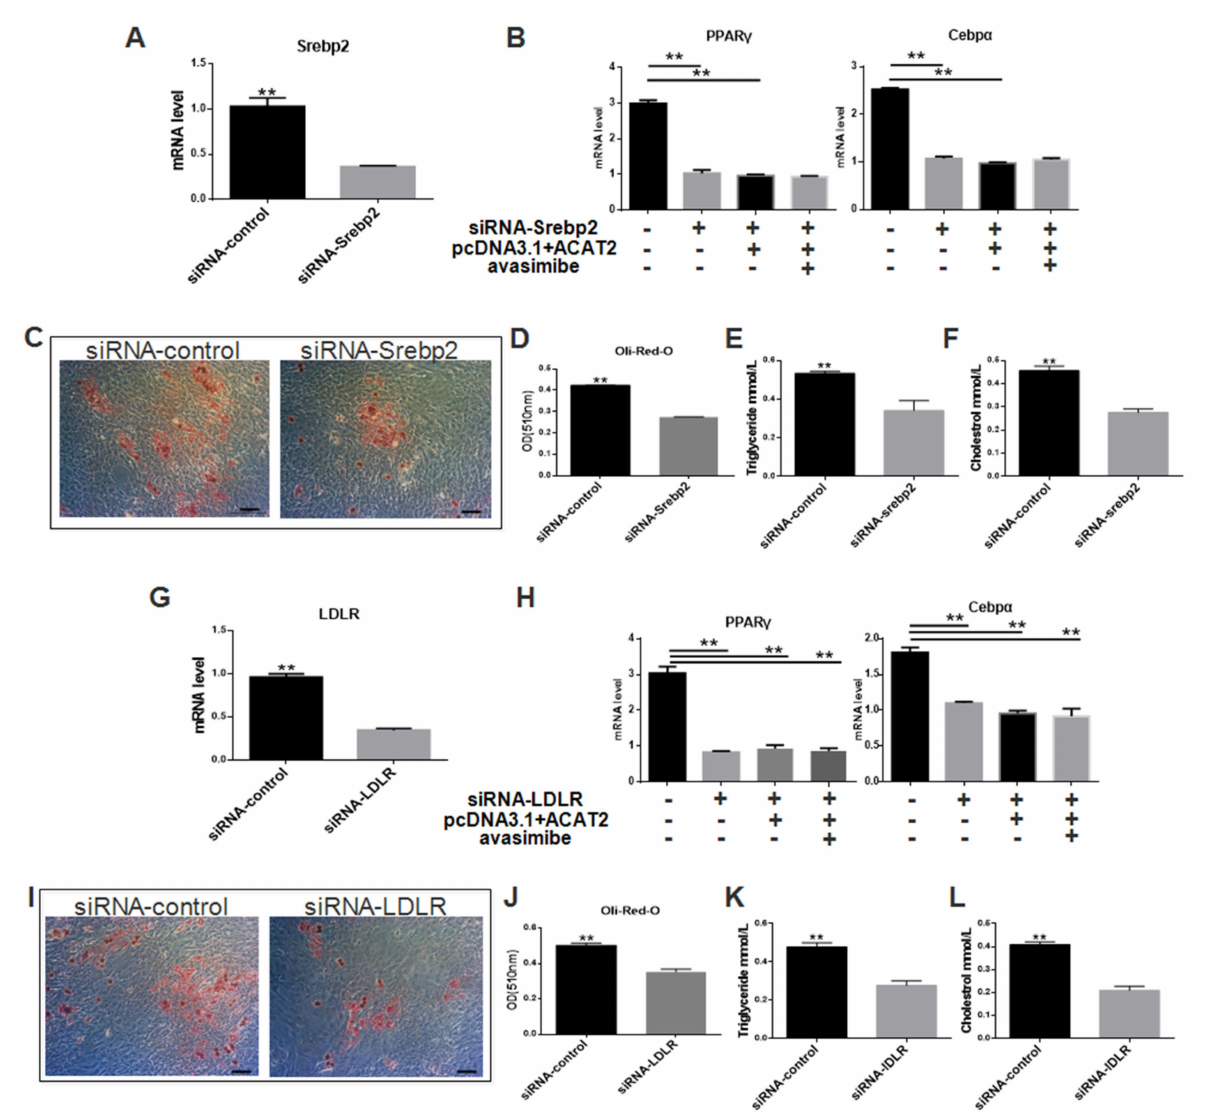
Figure 5. Blocking srebp2/ldlr signal can inhibit pig intramuscular pre-adipocytes differentiation, and the effect of ACAT2 disappears. ( A ) The interfering efficiency of siRNA-Srebp2. ( B ) mRNA levels of ppar γ and cebp α in different treatment groups. ( C ) Oil Red O staining in the groups of siRNA-control and siRNA-srebp2. ( D ) Quantification Oil Red O staining in the groups of siRNA- control and siRNA-srebp2. ( E ) Triglycerides levels in the groups of siRNA-control and siRNA-srebp2. ( F ) Cholesterol levels in the groups of siRNA-control and siRNA-srebp2. ( G ) The interfering efficiency of siRNA-ldlr. ( H ) mRNA levels of ppar γ and cebp α in different treatment groups. ( I ) Oil Red O staining in the groups of siRNA-control and siRNA-ldlr. ( J ) Quantification Oil Red O staining in the groups of siRNA-control and siRNA-ldlr. ( K ) Triglycerides levels in the groups of siRNA-control and siRNA-ldlr. ( L ) Cholesterol levels in the groups of siRNA-control and siRNA-ldlr. Data are expressed as means ± SEM ( n = 3), representative of 3 independent experiments. The statistical significance was calculated by One-way ANOVA, ** p <